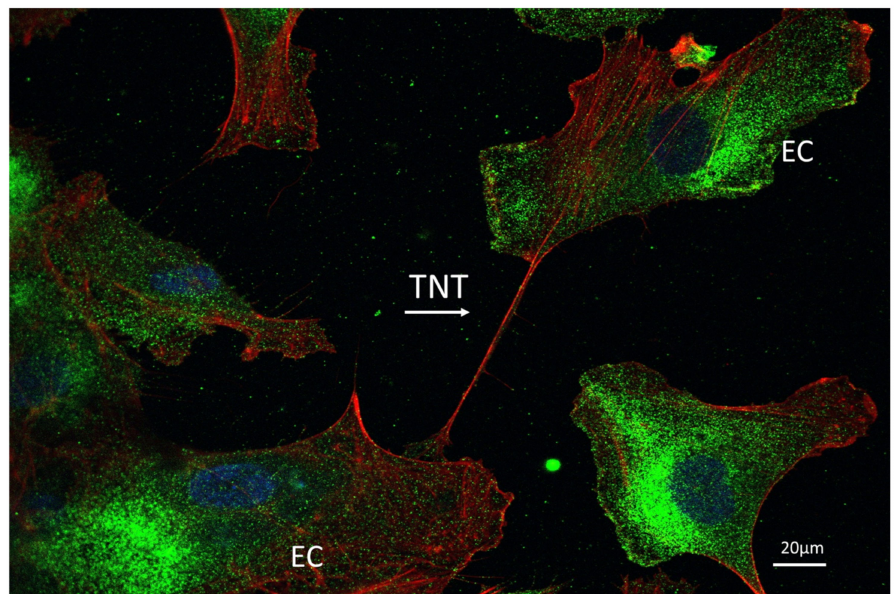
Figure 3. A representative confocal imaging of TNT between two endothelial cells. CoImmunostaining for F-actin (red) and MHC class I molecules (green) on human aortic EC culture. Nuclei are staining with DAPI (blue) and costainings are visualized as superimposition of images (magnification: 600 ×